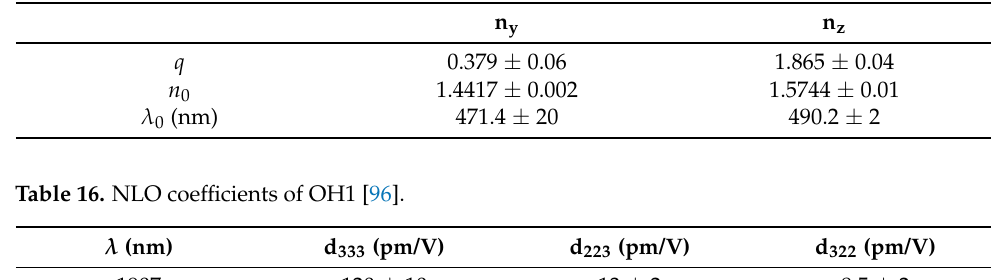
Table 15. Sellmeier parameters for the refractive index dispersion of Equation (25) [96].